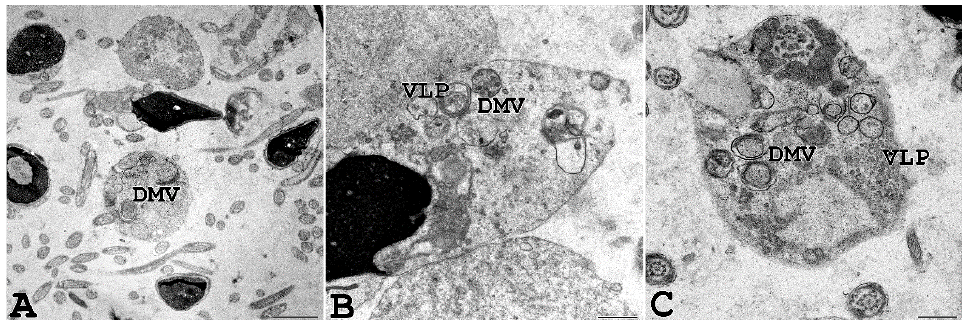
Figure 7: Ejaculated human sperm of a man affected by COVID-19. Human sperm from a donor man with a symptomatic form of COVID-19 were analysed, and virus-like particles (VLP) can be seen inside double-membrane vesicles (DMV) localized in the cytoplasmic residues embedding sperm tails, often coiled inside. Scale bar: ( A ) = 0.2 µm; ( B , C ) = 0.5 µm.